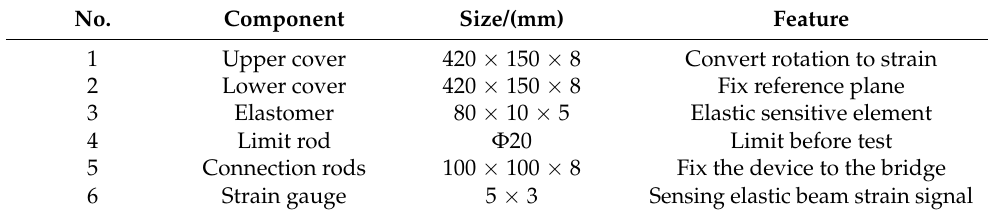
Table 2. Dimensions and features of the inclinometer components.